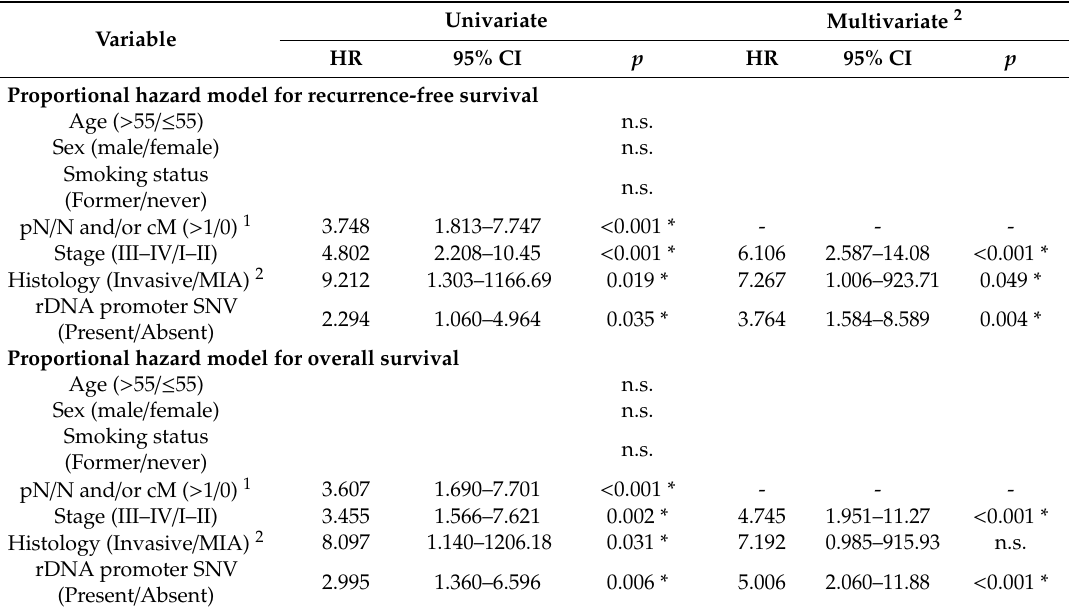
Figure 7. Overall survival stratified by ( A ) germline single-nucleotide variants (SNVs) at any site at positions +1 to +100 in the rDNA promoter region (presence versus wild type (WT)) in 82 lung adenocarcinoma (LUAC) patients, and ( B ) germline SNV at positions +1 to +100 in the rDNA promoter region (presence versus WT) in Stage I LUAC excluding MIA ( n = 42), and ( C ) in Stage I/II LUAC excluding MIA ( n = 60). Table 4. Univariate and multivariate Cox regression analyses of recurrence-free survival and overall survival of lung adenocarcinoma patients.